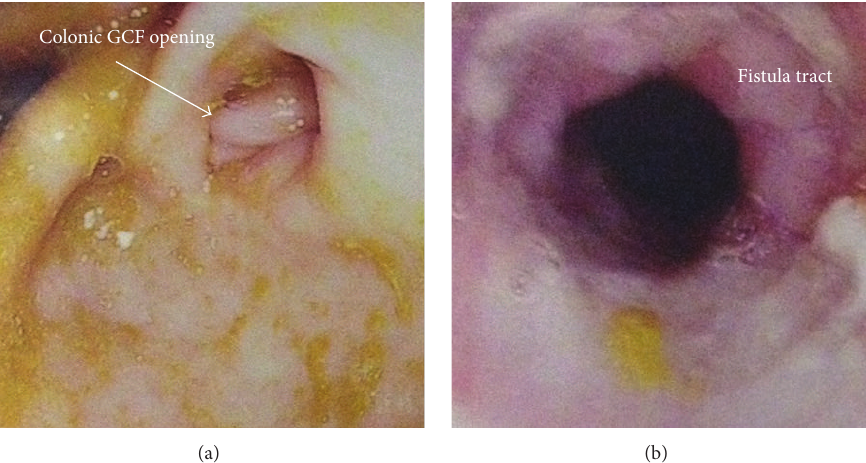
Figure 2: (a) Colonoscopy showing the colonic opening of the GCF. (b) Colonoscopy showing the lumen of the fistula tract.